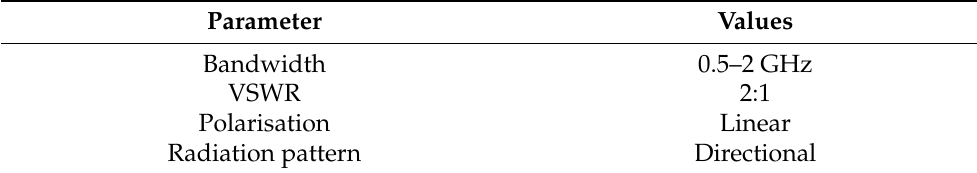
Table 4. Characteristics of LPDA.